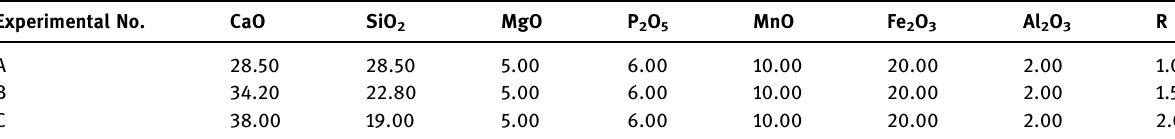
Table 1: Chemical compositions of the experimental slag ( mass fraction, % )